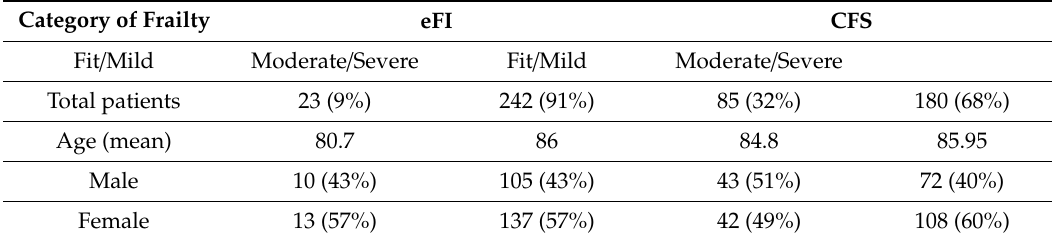
Table 1. Demographic characteristics of the study population.